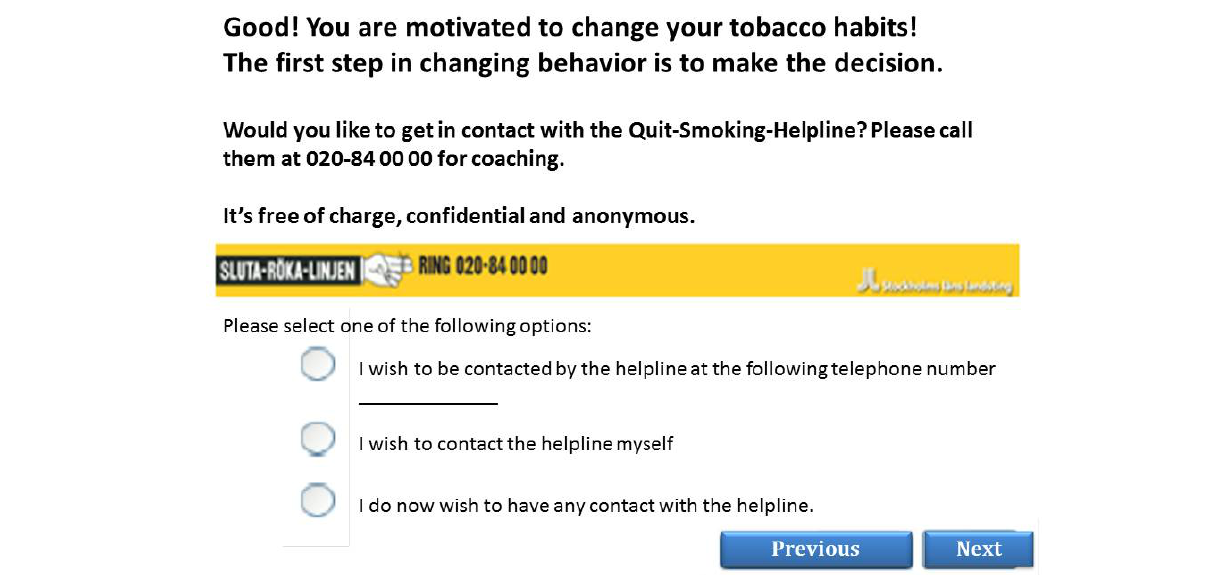
Figure 3. Screenshot of referral to The Swedish National Tobacco Quitline.